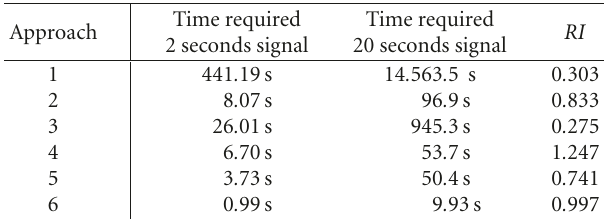
Table 1: Results for the FIR